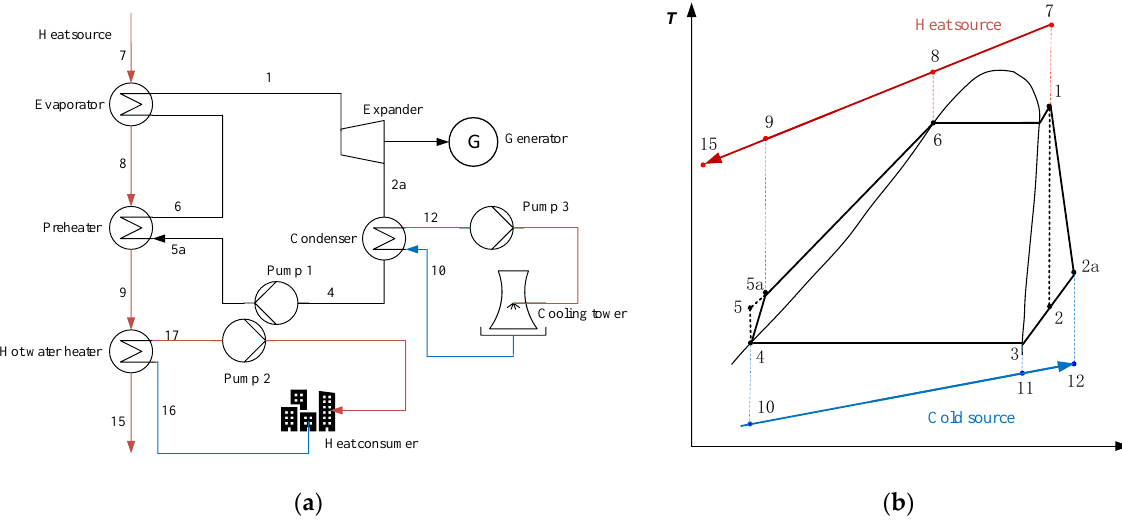
Evaporator Evaporator